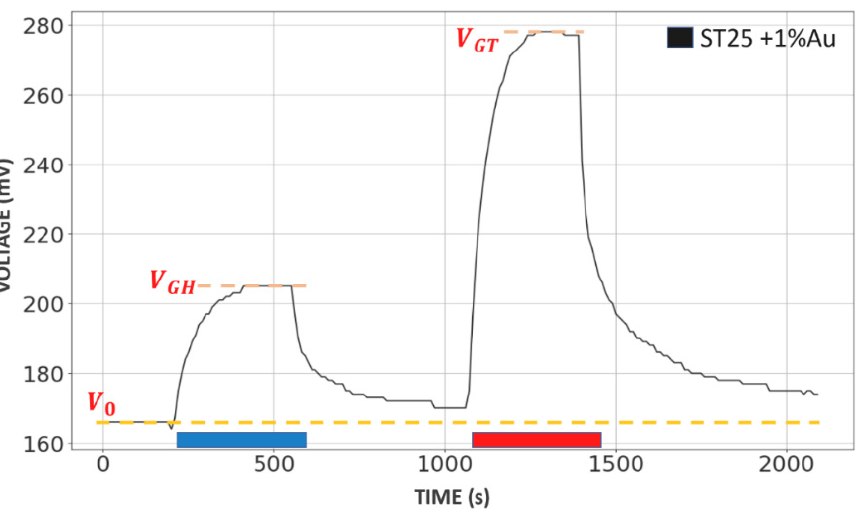
Figure 1. Example of an output voltage sensor signal. A ST25 + 1%Au sensor was exposed to a stream of clean and dry air (giving a steady voltage response of amplitude V 0 ; orange dotted line) in between a stream of air polluted with the blood headspace volatile organic compounds (VOCs) of a healthy subject (HB; which timing is shown by the thick blue line; response attained a steady state amplitude V GH , orange dotted line) and of a tumor affected one (TB; thick red line; steady state amplitude V GT , orange dotted line). The steady state was considered to be achieved when voltage did not change more than 2/3 mV in 30 s.